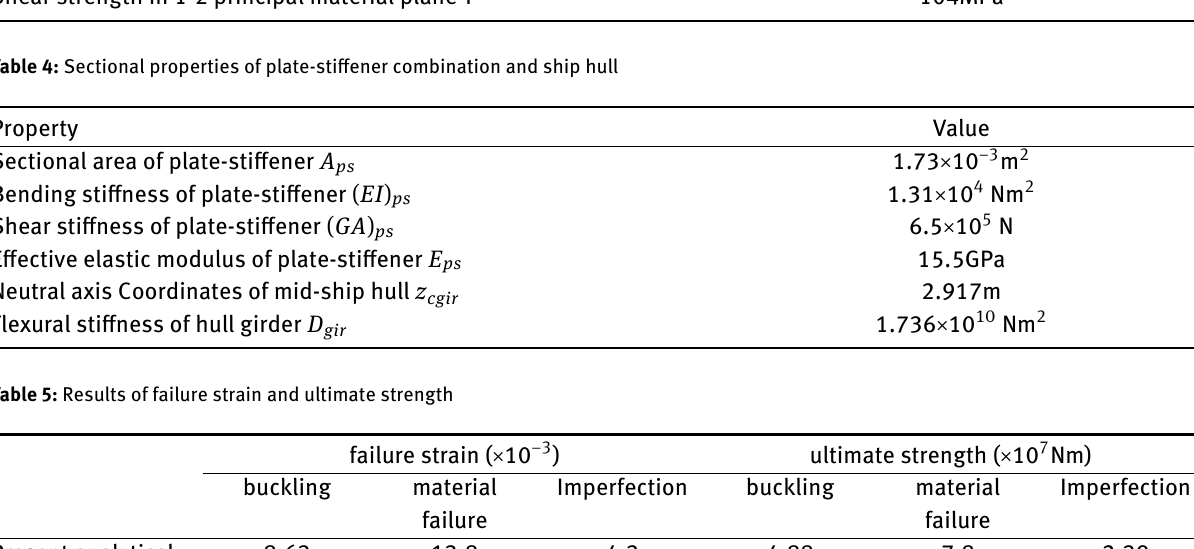
failure strain ( × 10 −3